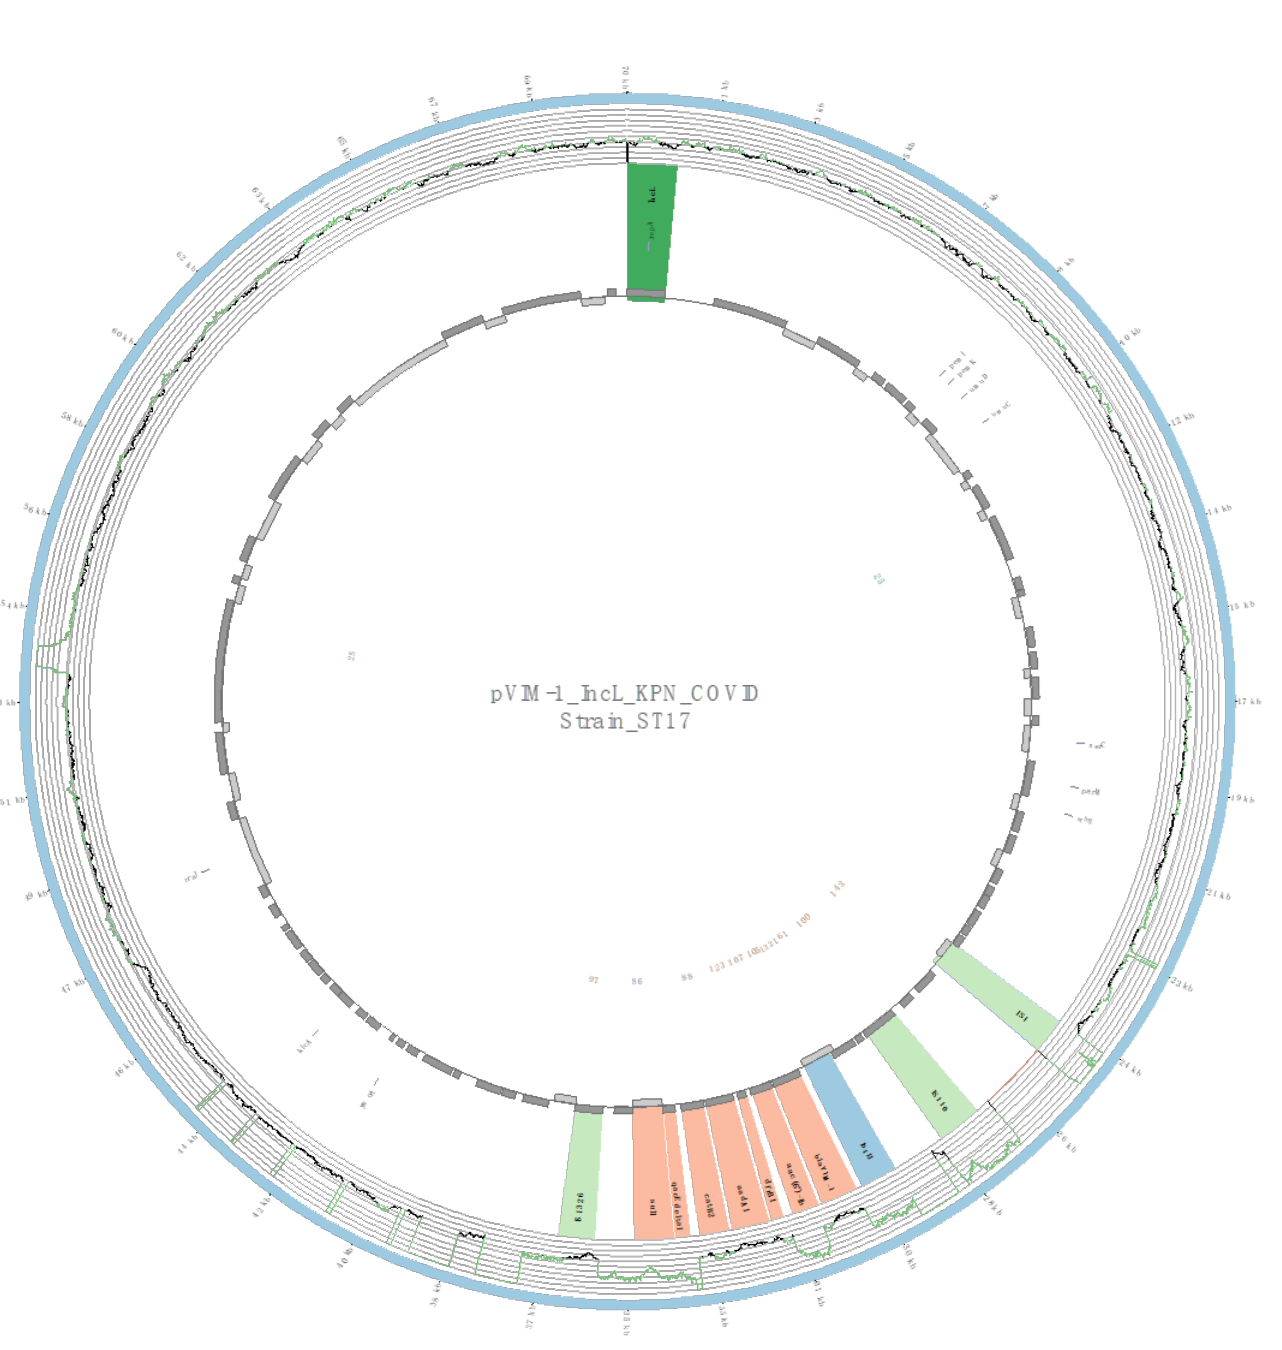
Figure 4. Overview of the IncL plasmid harboring bla VIM-1 detected in a strain of ST17: The figure represents the homology between the IncL plasmid and a highly similar plasmid identified in the GenBank database (blue outer ring). The graph represents the reads mapped against this reference sequence with a depth of coverage ranging from 0 (red) to 500, with orange indicating values of 1 to 20 reads and green indicating values higher than 200 reads. Gray boxes represent the coding sequence from automatic annotation, with dark and light colors being used when they were found on the forward or the reverse strand, respectively. Colored stripes represent a more detailed annotation that includes antibiotic resistance genes in red, insertion sequences (IS) in light green, integrases in blue, and Rep genes in dark green. The homology between the reference plasmid and the assembled contigs is represented in the inner ring, with each contig colored according to its number.